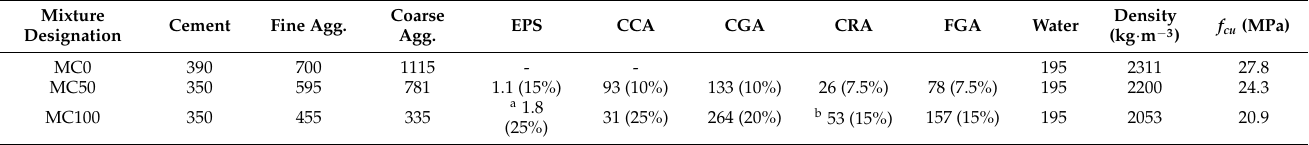
Table 1. Proportions of the concrete mixtures per kg · m − 3